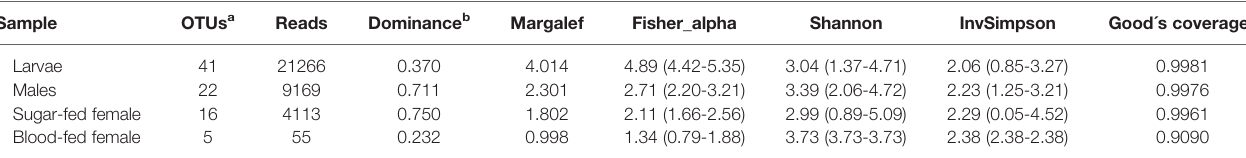
TABLE 1 | Summary of community richness and alpha diversity per Cx. quinquefasciatus instars. Sample OTUs a Reads Dominance b Margalef